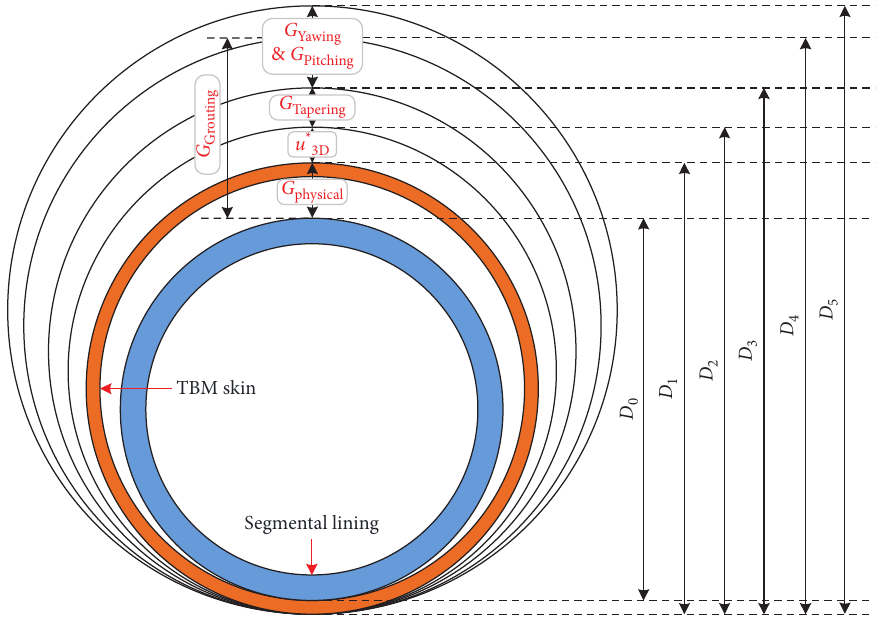
Figure 3: Schematic of equivalent diameter based on GAP parameter [46].